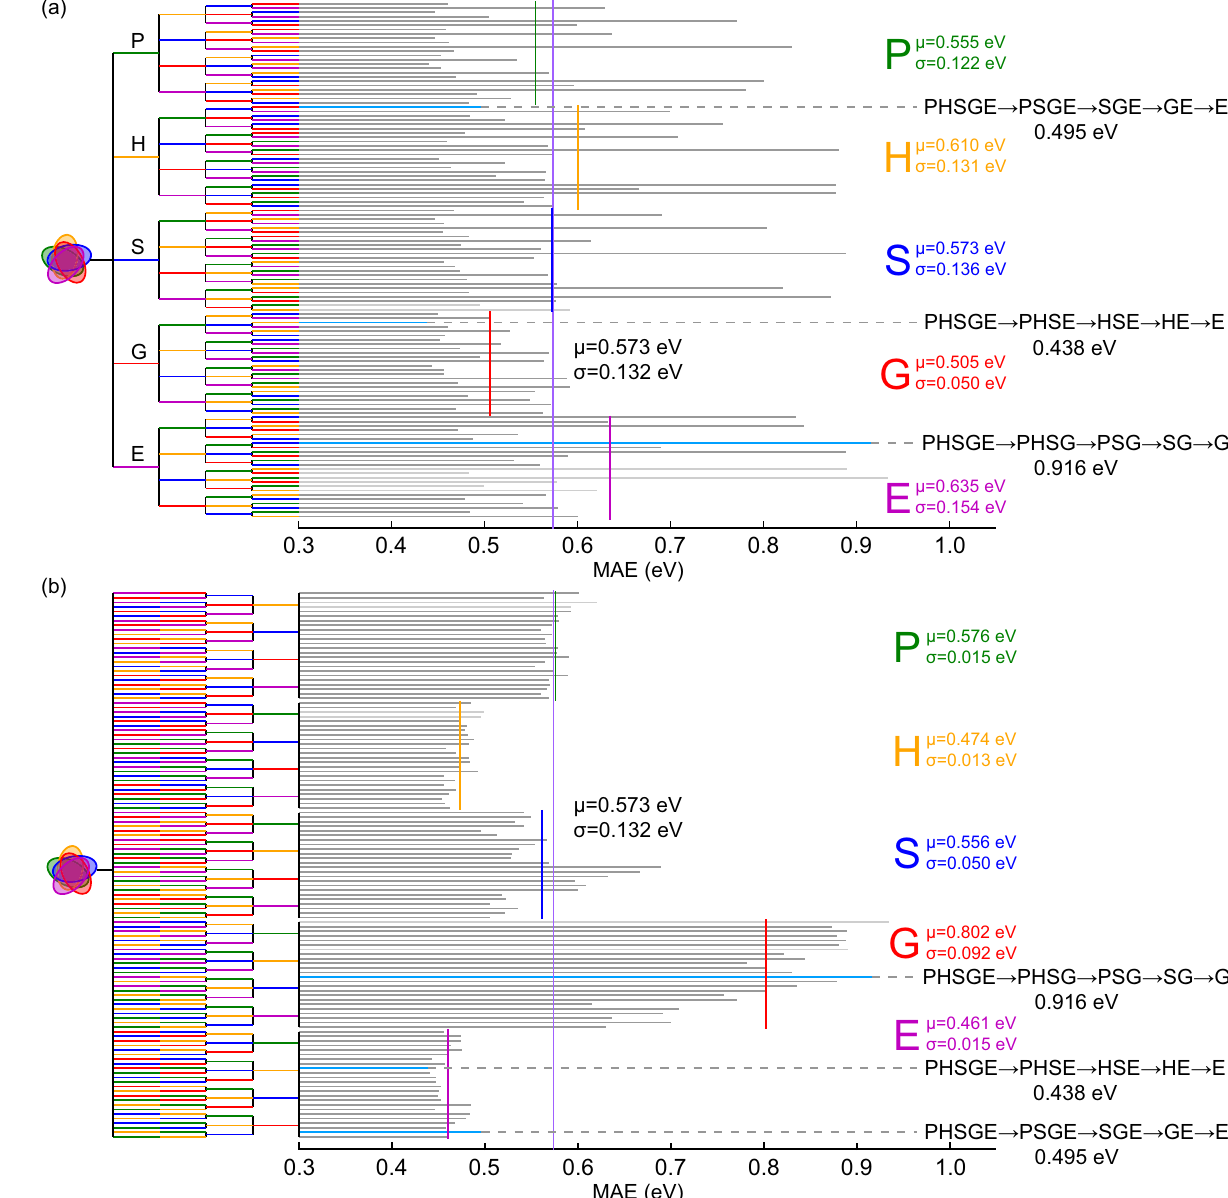
Supplementary Table 4. As a last assessment of our denoising procedure, we compare the fi nal results obtained after one step of the denoising procedure with those computed using MFGNet 25 ,